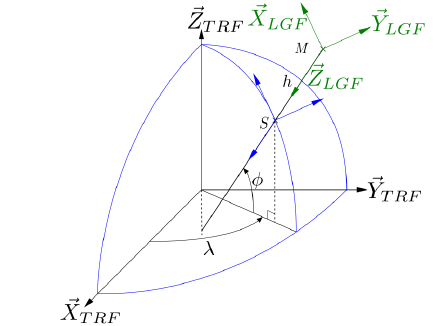
Figure 3. Local geodetic frame (LGF) (navigation frame), denoted by ( n )